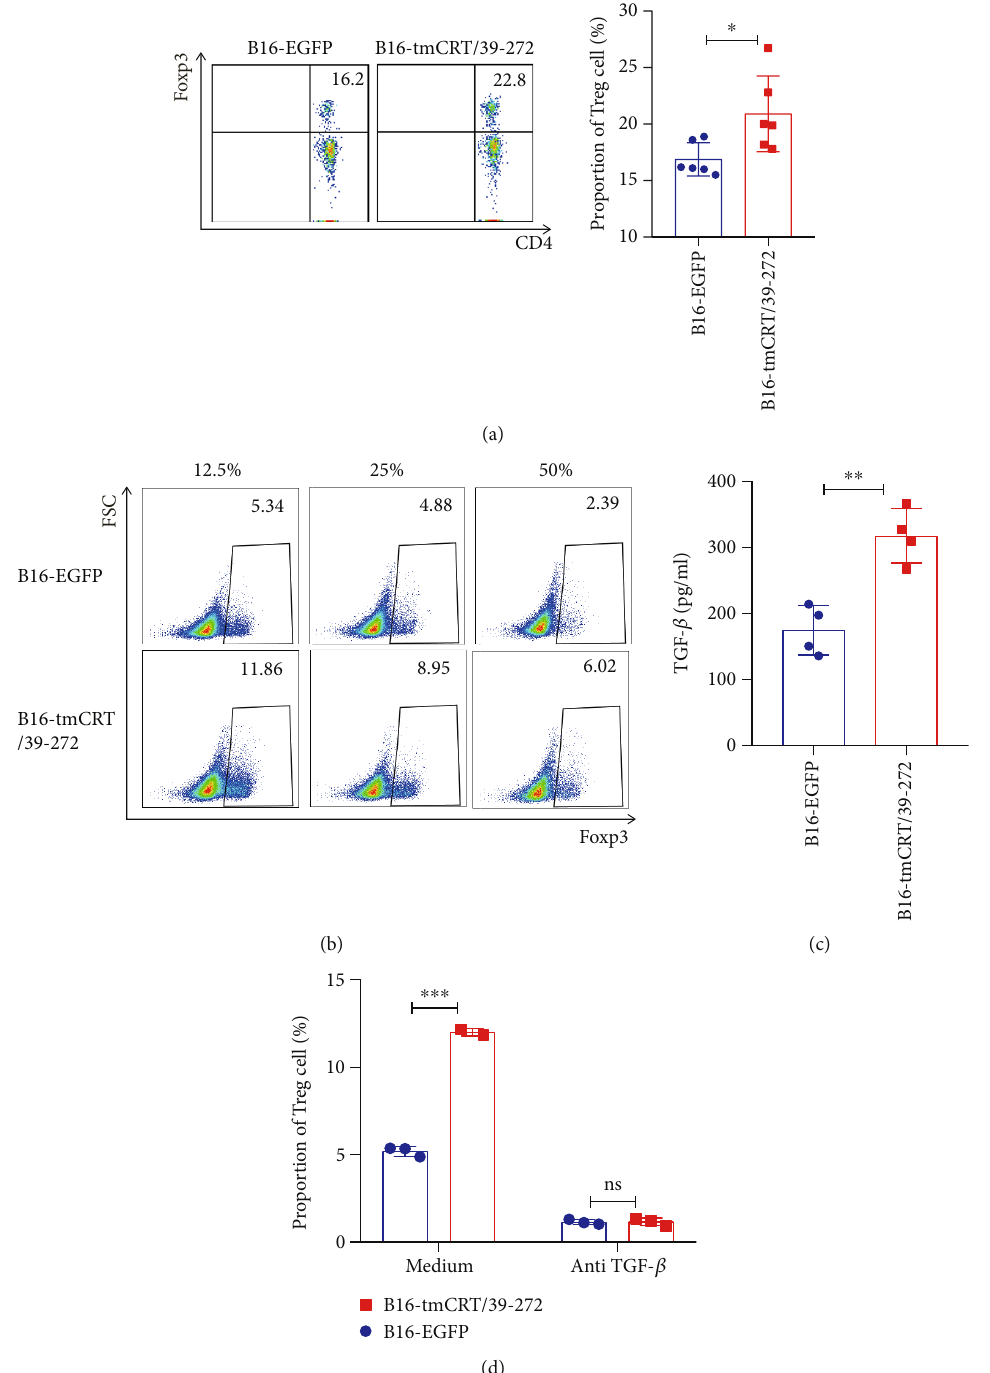
Figure 4: tmCRT/39-272 promoted Treg di ff erentiation through TGF- β secretion by M2 macrophages. (a) Female Foxp3-GFP C57BL/6 mice ( n = 6 ) were s.c. injected with B16-EGFP or B16-tmCRT/39-272 cells ( 5 × 105/100 μ L/mouse). Spleen cells were collected from the mice 12 days postinoculation. The proportions of Tregs were analyzed by FACS. FACS dot plots and the statistical results of Tregs are shown in panel. (b) Naïve CD4 + T cells puri fi ed from the spleens of Foxp3-GFP C57BL/6 mice, di ff erent doses (50%, 25%, 12.5%) of B16-EGFP or B16-tmCRT/39-272 cell supernatants were added to the wells for 72h. Single cells were collected and the populations of Treg analyzed by FACS. (c) ELISA of TGF- β in the supernatants of C57BL/6 mouse bone marrow cells cultured in M-CSF conditioned medium, followed by the addition of γ -ray-treated B16-EGFP or B16-tmCRT/39-272 cells. (d) B16-EGFP or B16-tmCRT/39-272 cell supernatants (12.5%) were added to the naïve CD4 + T cells (puri fi ed from the spleens of Foxp3-GFP C57BL/6 mice) and treated with or without TGF- β -blocking antibody (10 ng/mL) for 72 h. Single cells were collected and analyzed by FACS. The experiments were repeated three times. ∗ P < 0 : 05 , ∗∗ P < 0 : 01 , ∗∗∗ P < 0 : 001 , ns: not signi fi